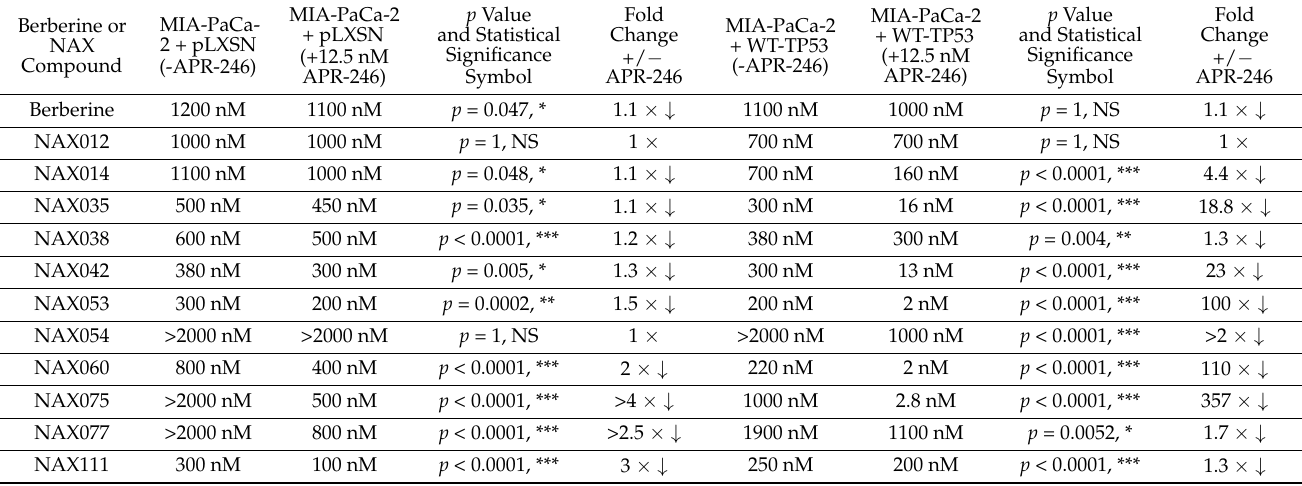
Table 1. Effects of WT-TP53 on the sensitivity of MIA-PaCa-2 PDAC cells to APR-246 1